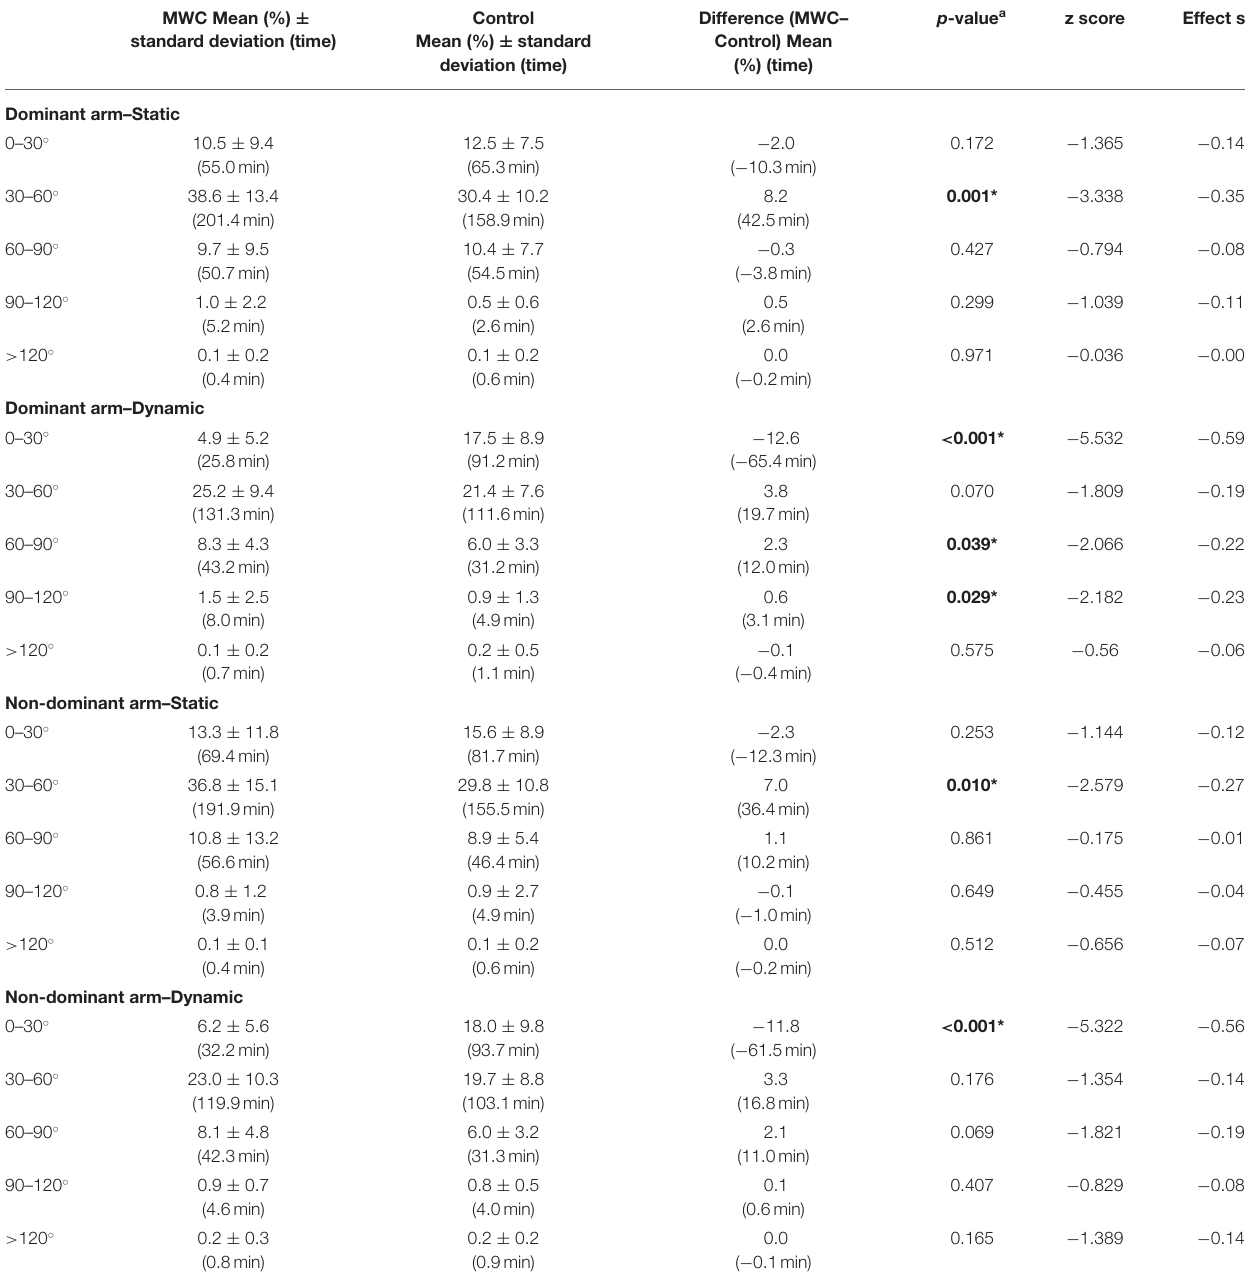
TABLE 2 | The percentage of the day (and minutes) the MWC and control cohorts spent static and dynamic in each humeral elevation range. MWC Mean (%) ± standard deviation (time)